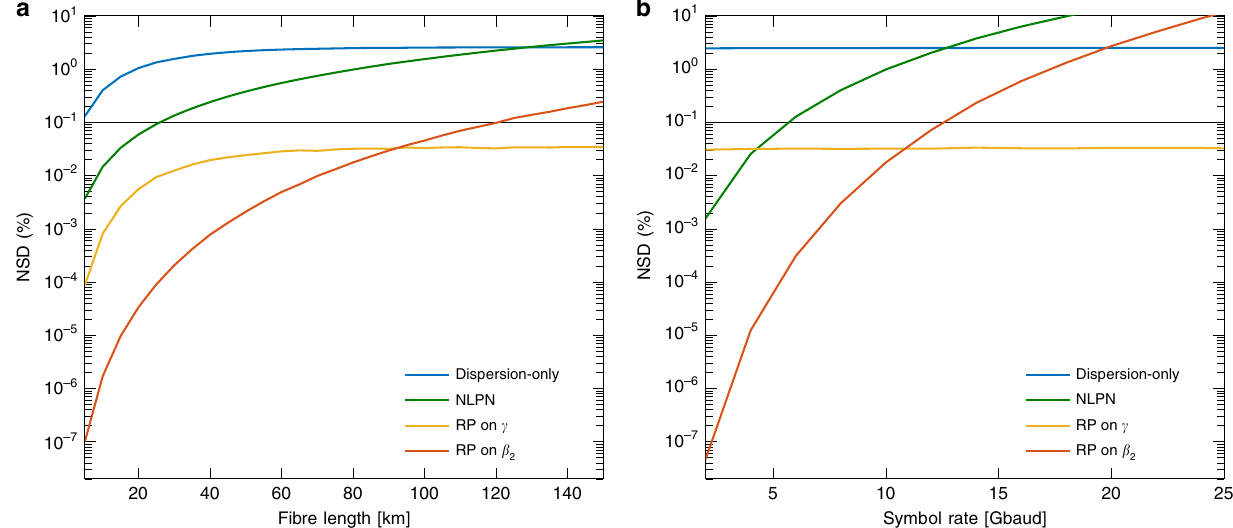
Fig. 6 NSD versus fi bre length and symbol rate for the four models. The system consists of an NZDSF with fi xed input power 5 dBm. a NSD versus fi bre length at a symbol rate of 10 Gbaud. b NSD versus symbol rate for a fi bre length of 80 km. Changes in fi bre length or symbol rate result in a wider range of NSD variation for RP on β 2 than for RP on γ .